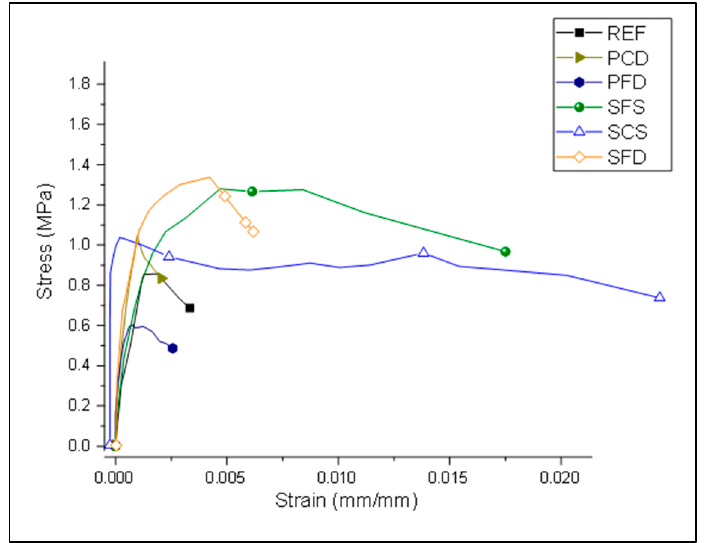
Figure 15. Stress–strain curve of reference and strengthened specimens.